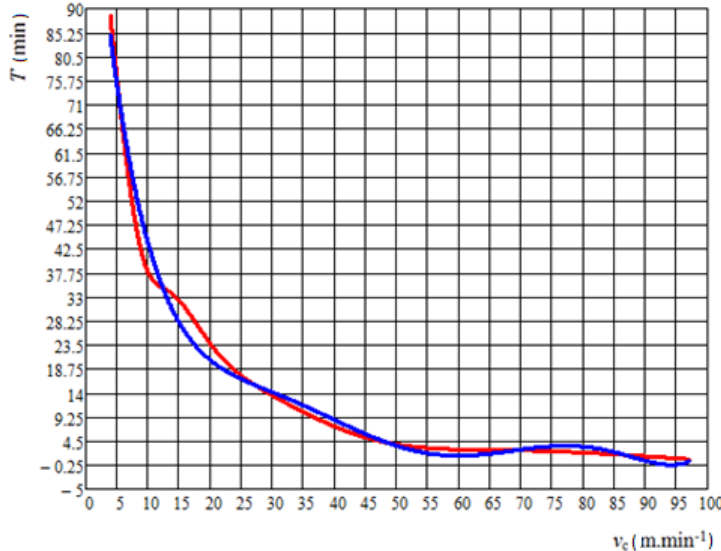
Figure 10. Regression analysis of T-v c dependence for HSS—conventional lathe (red curve—values obtained from experiment; blue curve—values determined in accordance with ISO 3685).